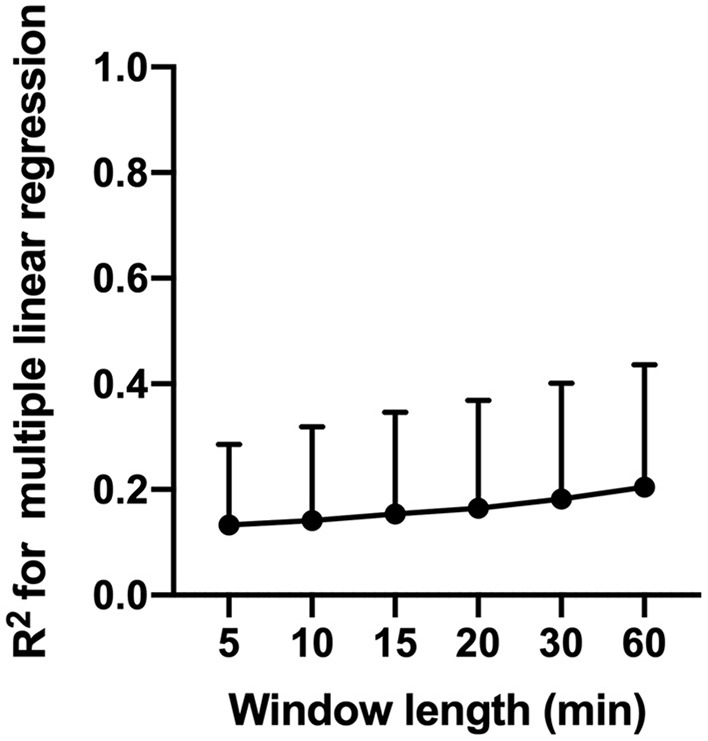
Results of multiple linear regression analysis with MAP and CO2 and independent variables and CBFv as a dependent variable. The figure shows changes in coefficient of determination (R2) as a function of window length use for regression analysis.